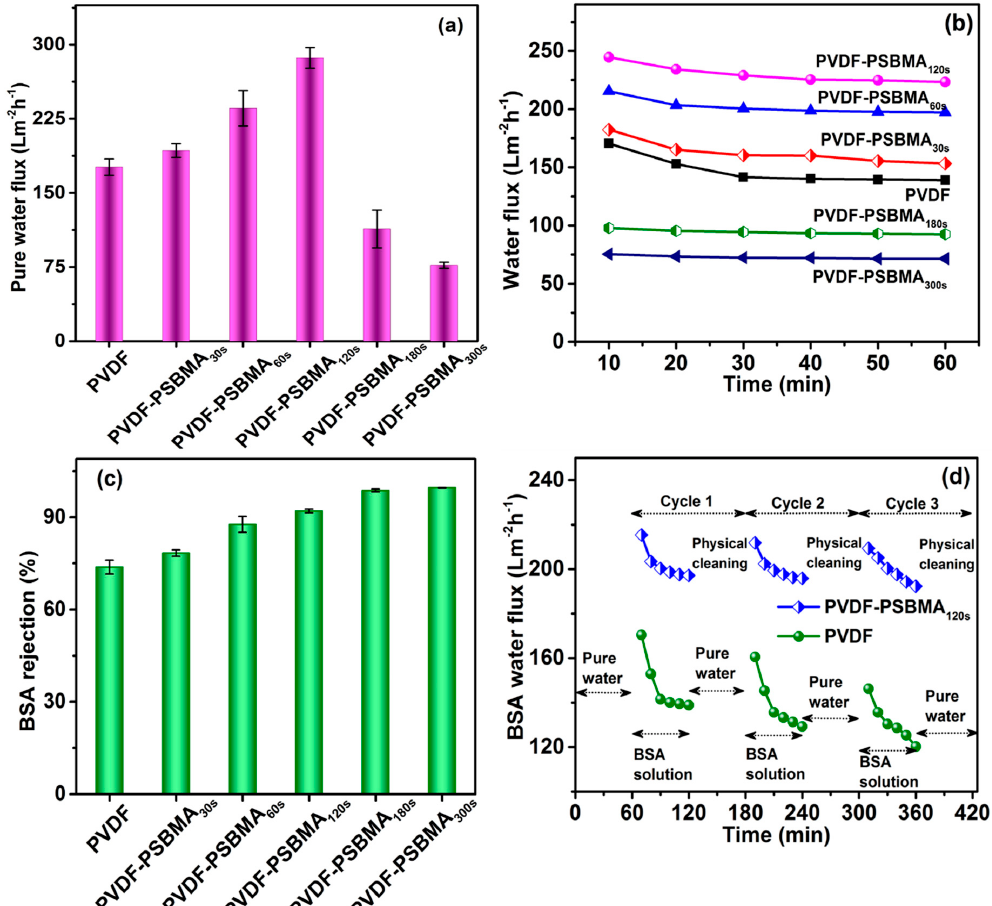
Figure 5. ( a ) The pure water flux of PVDF and PVDF-modified membranes at an applied pressure of 0.1 MPa. ( b ) The water flux of BSA feed solution at a pressure of 1 bar and ( c ) the corresponding rejection performance. ( d ) The antifouling performance of PVDF and PVDF / PSBMA membranes for three cycles in the BSA feed solution at a pressure of 0.1